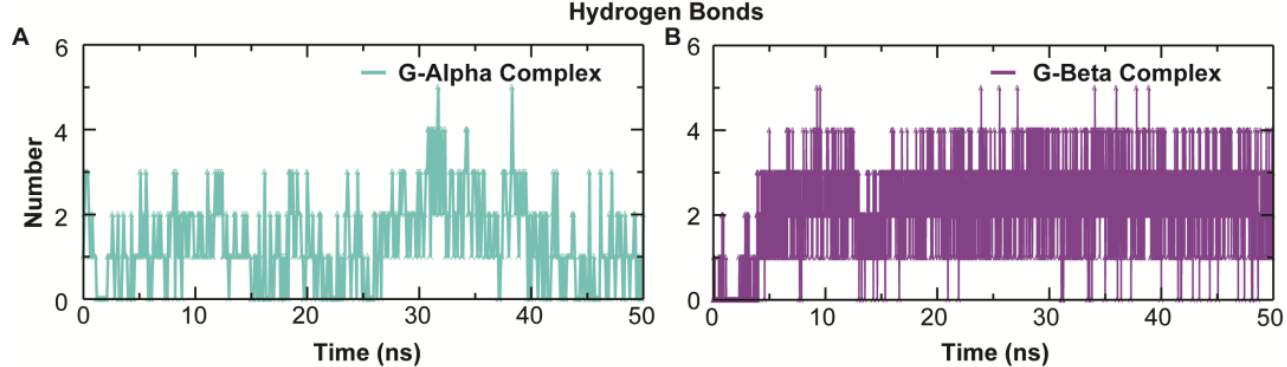
Figure 8. Dynamics of H-bonds between G- α ( A ) and β ( B ) subunit unit with ligand (Biploaroxin) complex systems with respect to time over the time scale of 50 ns.